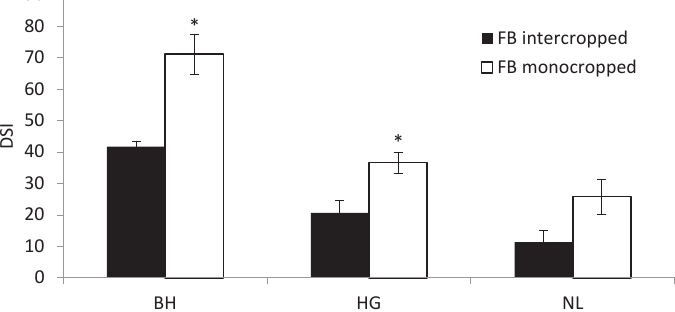
Fig. 1. Disease severity index (DSI) of leaf spots in monocropped (MFB) and intercropped faba bean (FB) in three field experiments, n=4. BH = Björkhaga, HG = Helgegården